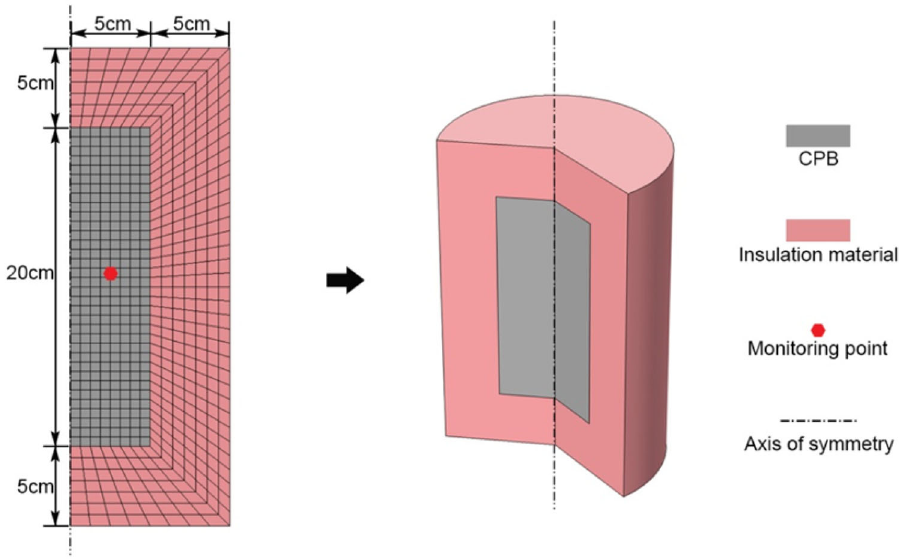
Fig. 7 Mesh and geometry of simulated cell